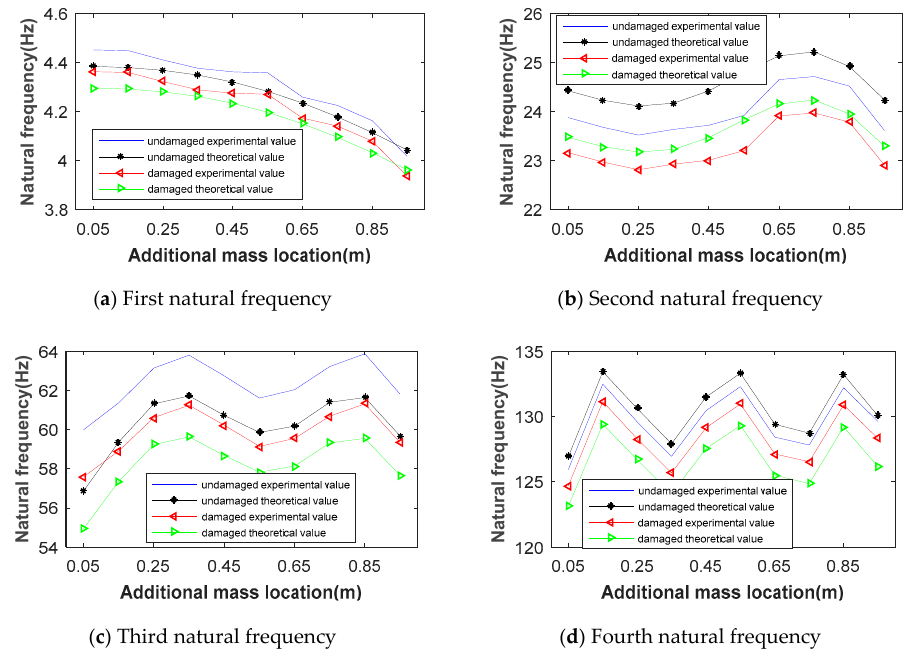
Figure 11. Experimental and computed values of the first four natural frequencies of the cantilever beam with a single damage.